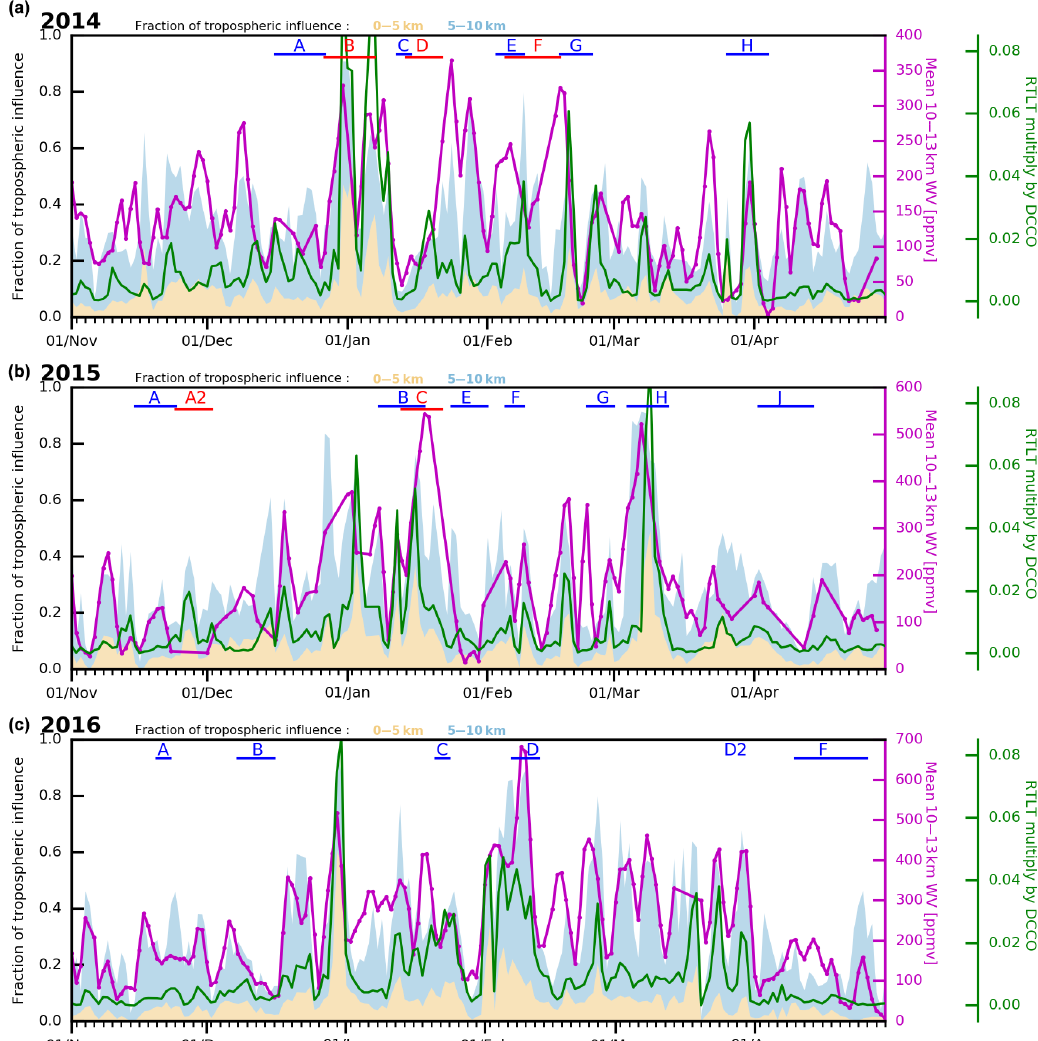
Figure 10. (a) Time evolution of fraction of tropospheric influence (spatially summed) for the lower troposphere (0–5km, sRTLT) in or- ange and the middle troposphere (5–10km, RTMT) in blue. The product of DCCO and RTLT is shown by a green line, and mean upper- tropospheric (10–13km) water vapor mixing ratio is shown in purple for austral summer 2014. (b, c) Same as top panel for austral summers 2015 and 2016, respectively. The letters in red and blue indicate periods with different tropical cyclones for each austral summer as shown in Fig.